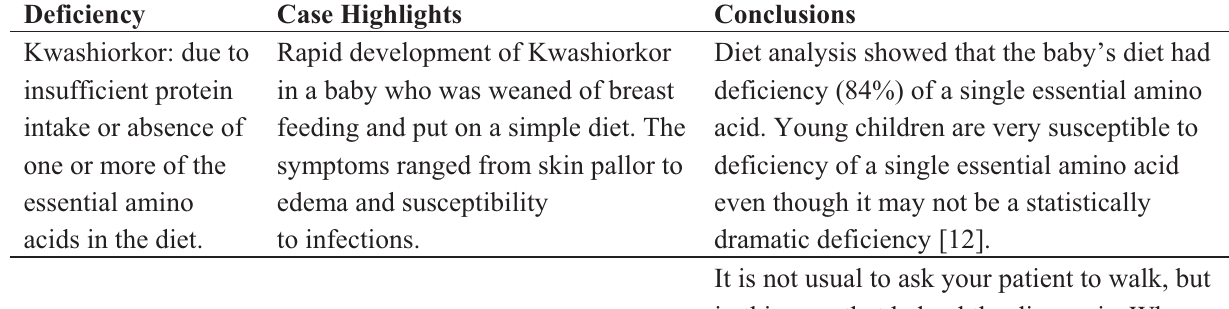
Table 1. Highlights of the nutritional pathology cases used in the